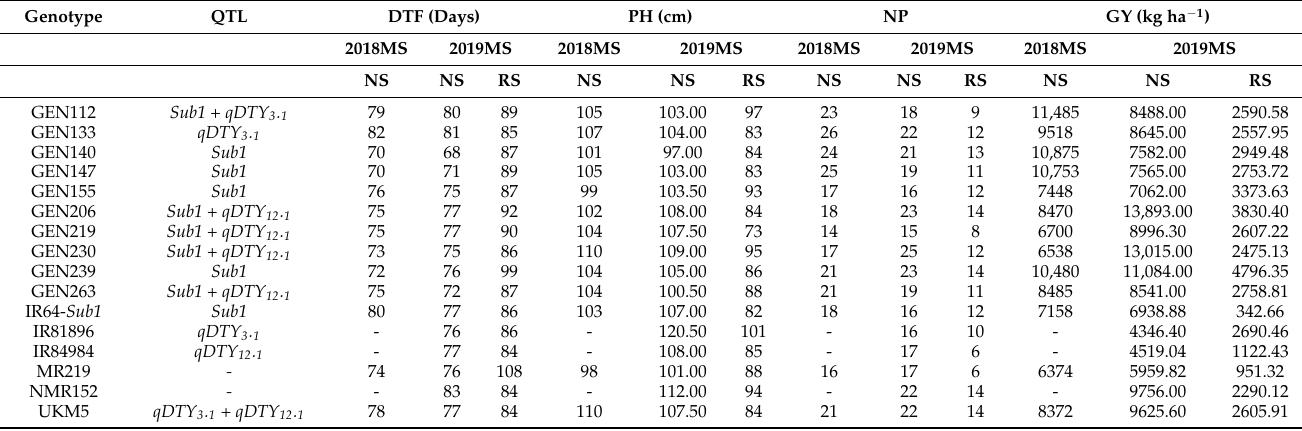
lines showed higher SR than UKM5 and IR64- Sub1 except GEN263 that was slightly lower than IR64- Sub1 . Table 4. Selected lines and the mean of days to 50% flowering (DTF), plant height (PH), number of panicle per plant (NP) and grain yield (GY) in non-stress (NS) and reproductive stage drought stress (RS) trials in 2018MS and 2019MS. Genotype QTL DTF (Days) PH (cm) NP GY (kg ha − 1 ) 2018MS 2019MS NS NS RS RS RS GEN112 Sub1 + qDTY 3 . 1 79 qDTY 3 . 1 Sub1 Sub1 Sub1 Sub1 + qDTY 12 . 1 75 Sub1 + qDTY 12 . 1 75 Sub1 + qDTY 12 . 1 73 Sub1 72 76 99 104 105.00 Sub1 + qDTY 12 . 1 75 72 Sub1 qDTY 3 . 1 qDTY 12 . 1